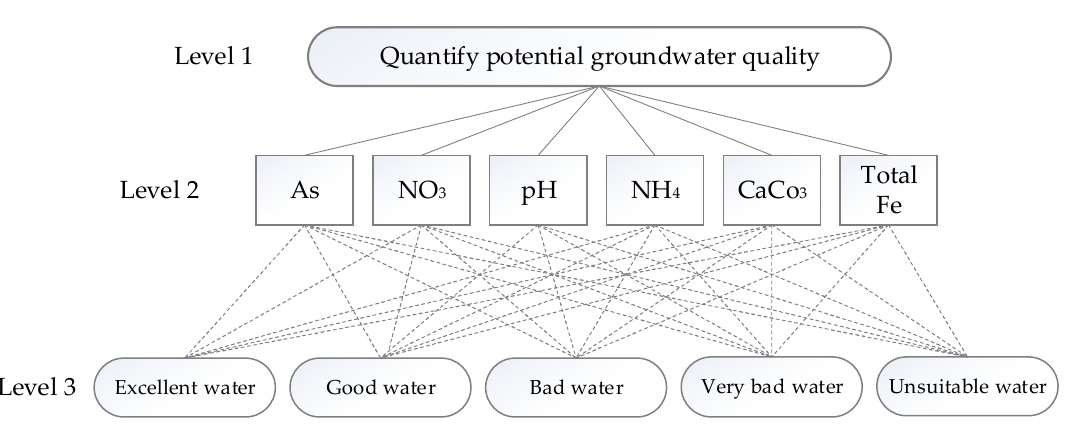
Table 1. Linguistic terms and the corresponding triangular fuzzy scale.